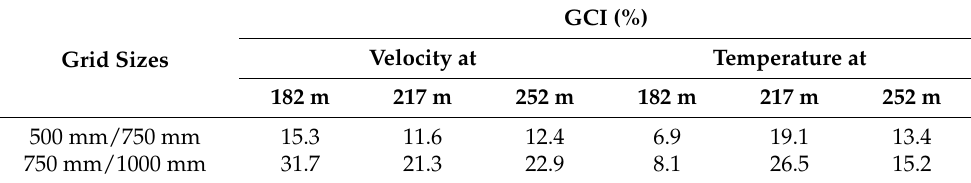
Table 7. Grid convergence of velocity and